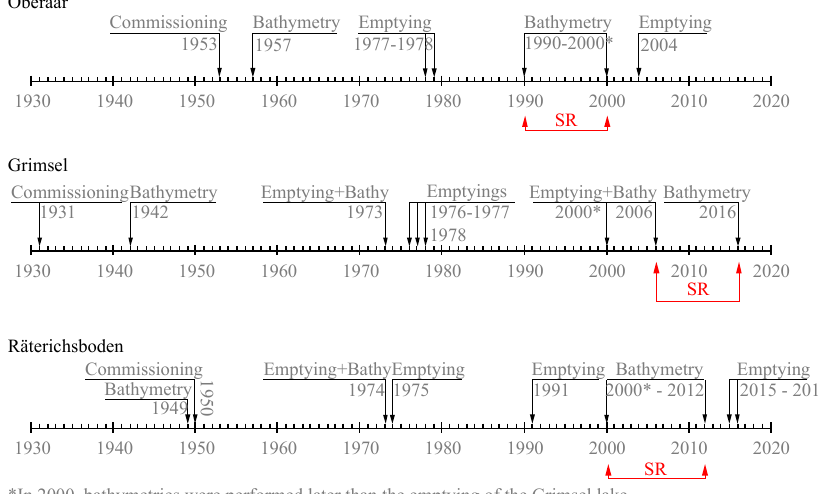
Figure 2. Chronology of the emptying events and bathymetric surveys conducted in the lakes of Oberaar, Grimsel, and Räterichsboden since their commissioning.